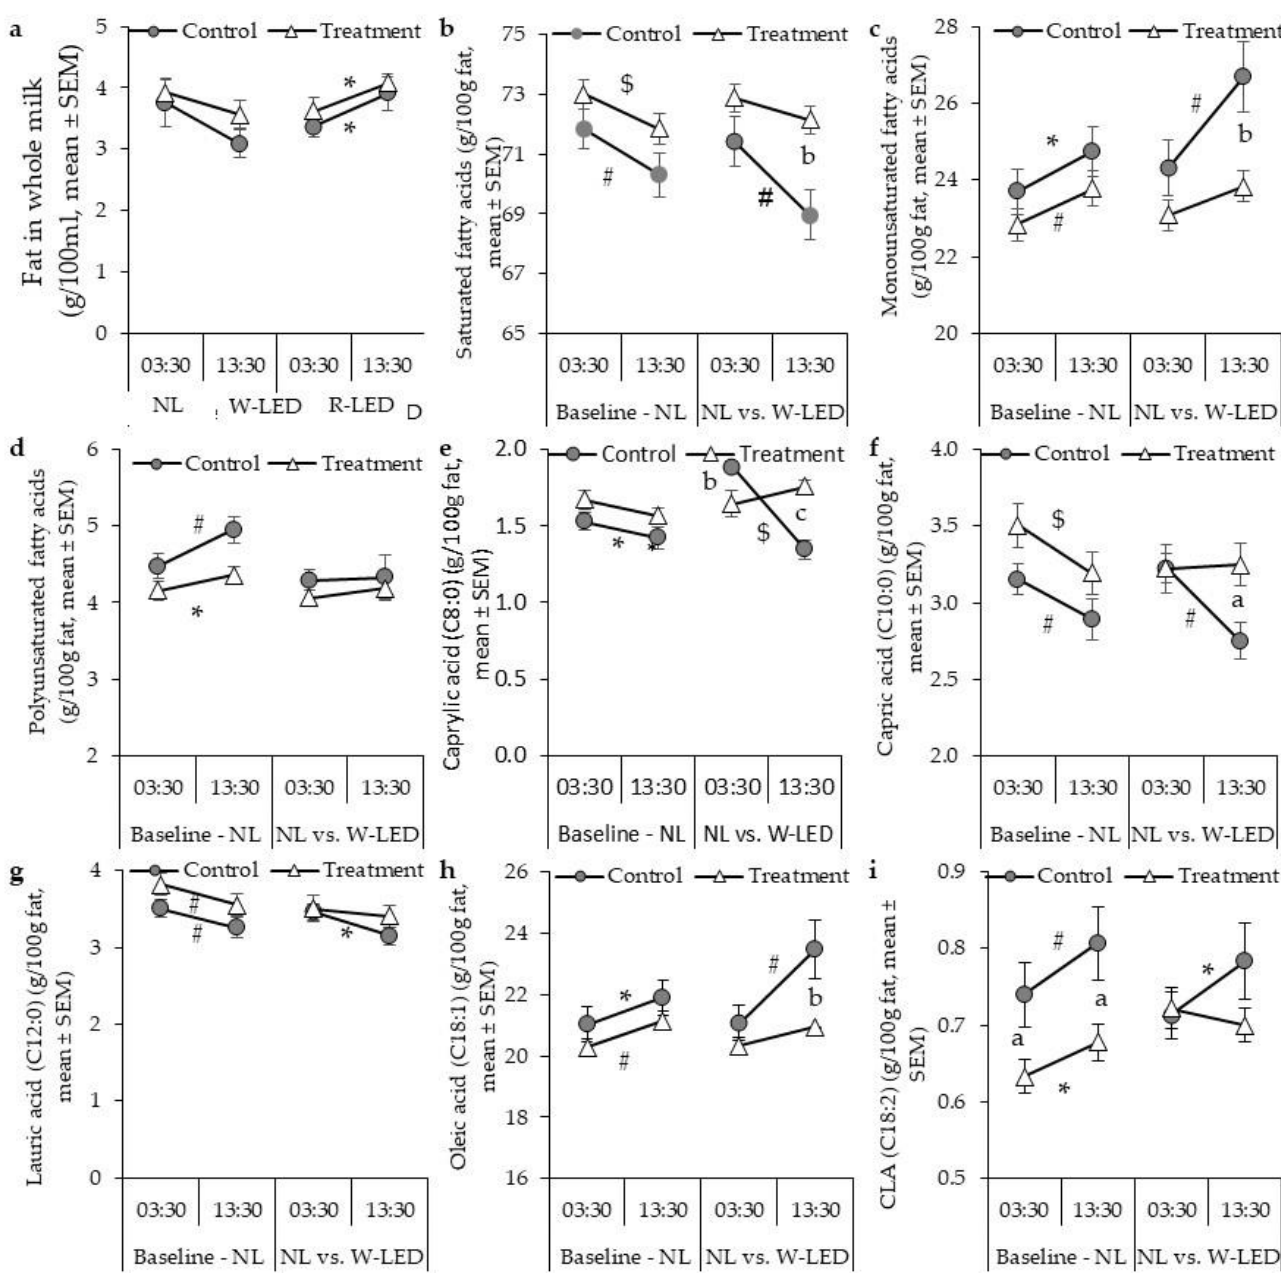
Figure 2. The effects of illumination condition and milking time on milk fat ( a ) and its composition, i.e., the concentration of saturated ( b ), mono ( c ), and polyunsaturated ( d ) fatty acids, and concen- tration of caprylic ( e ), capric ( f ), lauric ( g ) oleic ( h ) and conjugated linoleic ( i ) acid. The data are presented as mean ± standard error. Control, n = 15; treatment, n = 18. SFA, saturated fatty acids; MUFA, monounsaturated fatty acids; PUFA, polyunsaturated fatty acids; CLA, conjugated linoleic acid. *, p < 0.05; #, p < 0.01; $, p < 0.001, between milking hours, by Wilcoxon non-parametric test. a, p < 0.05; b, p < 0.01; c, p < 0.001, between treatments within milking hours, by Mann–Whitney non-parametric